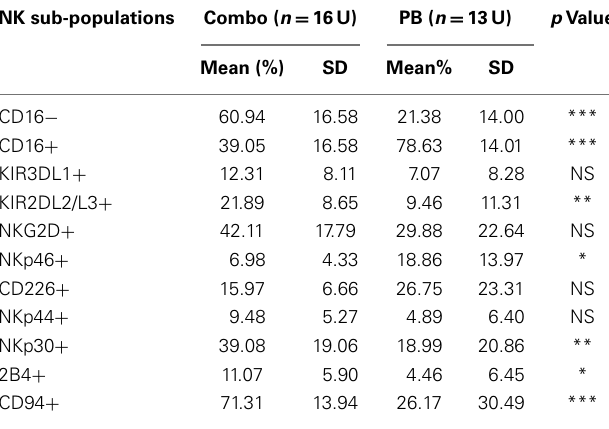
Table 2 | Comparison of sub-populations within pNK and PB NK cell